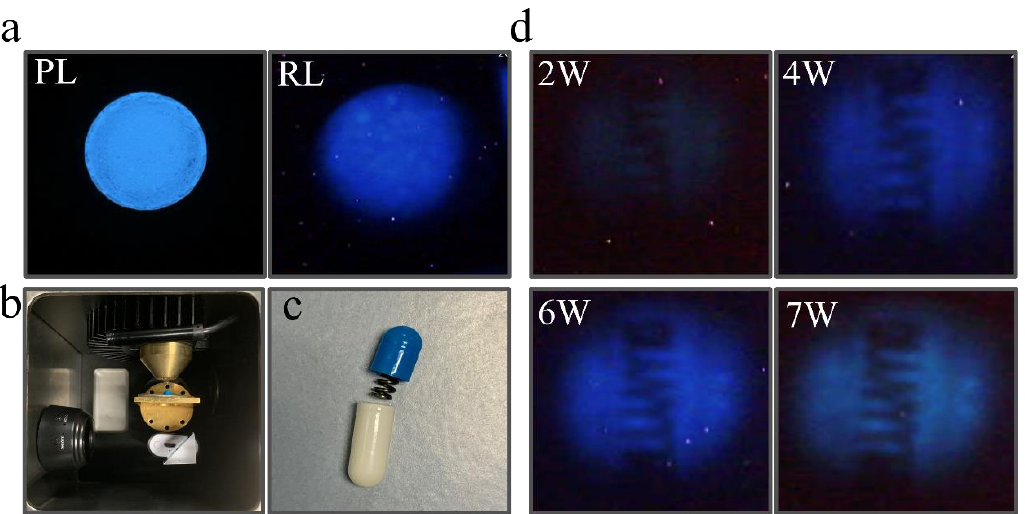
Figure 5. X-ray fluorescence imaging properties of the sample. ( a ) Photomicrographs of TEA 2 Cu 2 Br 4 scintillation screen under UV and X-ray illumination. ( b )Test specimen capsules and springs. ( c ) X-ray imaging of the internal spring of the capsule at different powers. ( d ) X-ray tube imaging pictures at different powers.